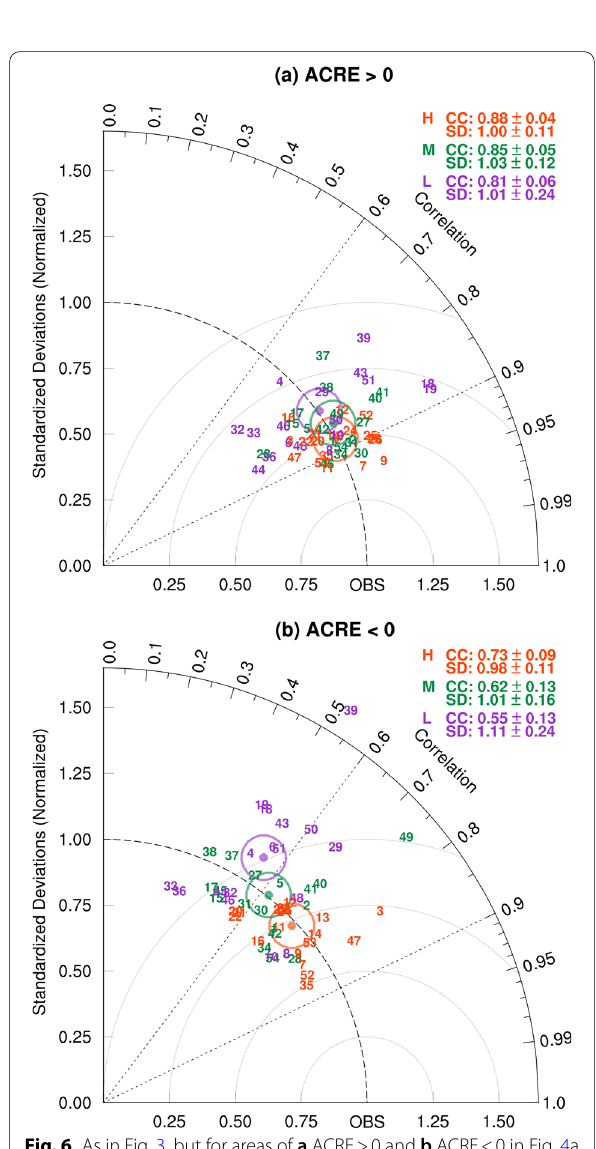
Fig. 6 As in Fig. 3, but for areas of a ACRE > 0 and b ACRE < 0 in Fig.